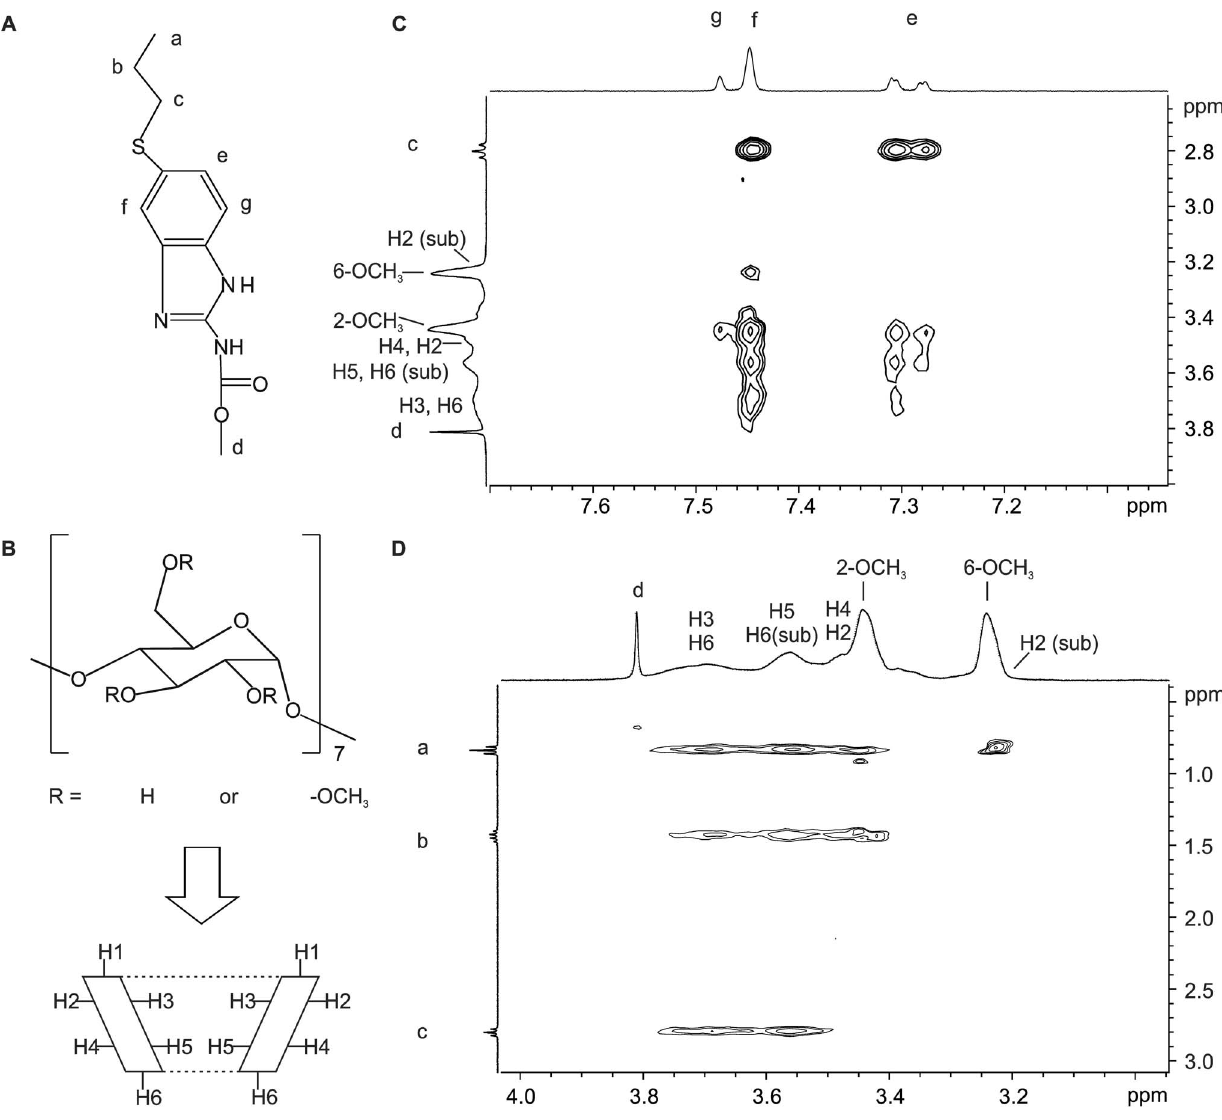
Figure 4. ROESY spectrum. A: ABZ proton labelling, B: RM- b -CD proton labelling. C and D: Plot of two dimensional ROESY spectrum of ABZ in the presence of RM- b -CD.